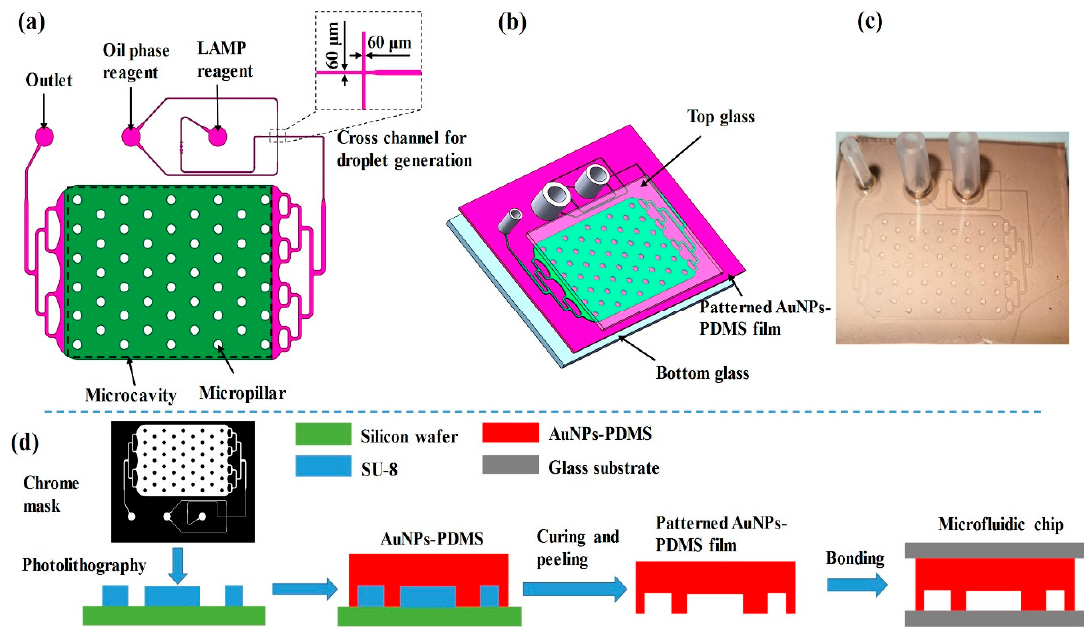
Figure 2. Schematic of the AuNPs-PDMS chip. ( a ) Top view. ( b ) Explosive view. ( c ) The appearance of digital LAMP chip. ( d ) Simplified fabrication process of the chip.